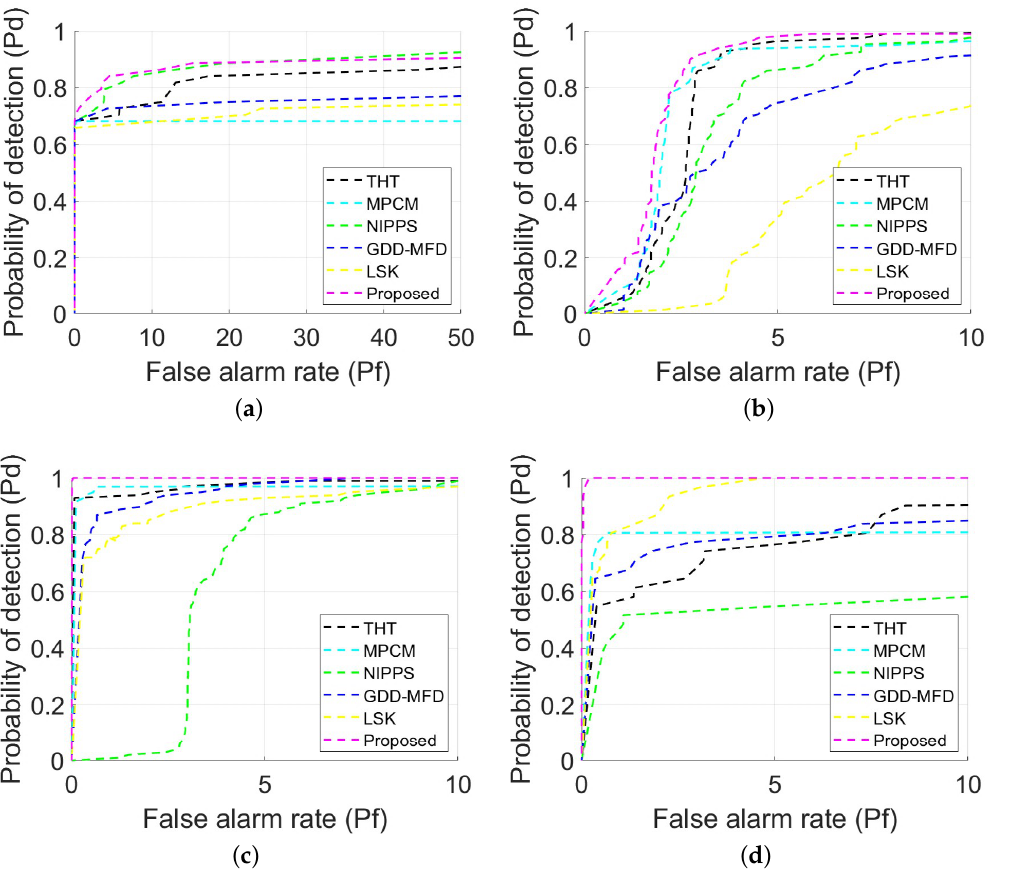
Figure 8. ROC curves of the proposed method and the baseline methods for the real test images: ( a ) ROC curves of Seq 1; ( b ) ROC curves of Seq 2; ( c ) ROC curves of Seq 3; and ( d ) ROC curves of Set